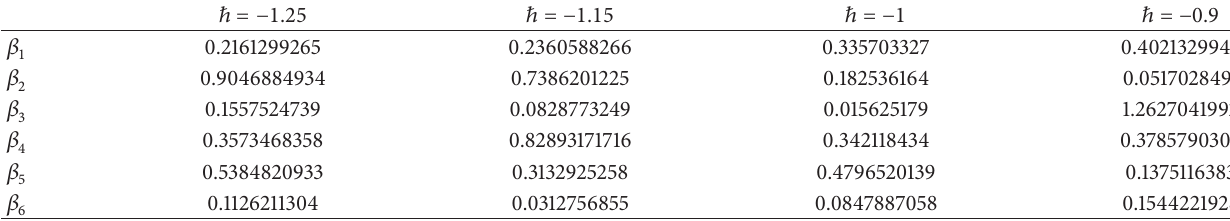
Table 3: Numerical values of 𝛽 𝑖 ’s for different values of ℎ in Example 2.